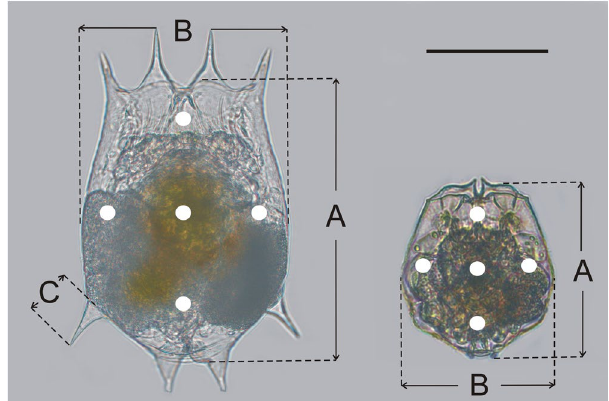
Figure 1. Biometric characters of Brachionus calyciflorus (left) and Brachionus angularis (right) measured in the present study. ( A ) body length; ( B ) body width; ( C ) length of posterolateral spine. White filled circles indicate the tested areas on each rotifer under atomic force microscopic observations. Scale bar = 100 µ